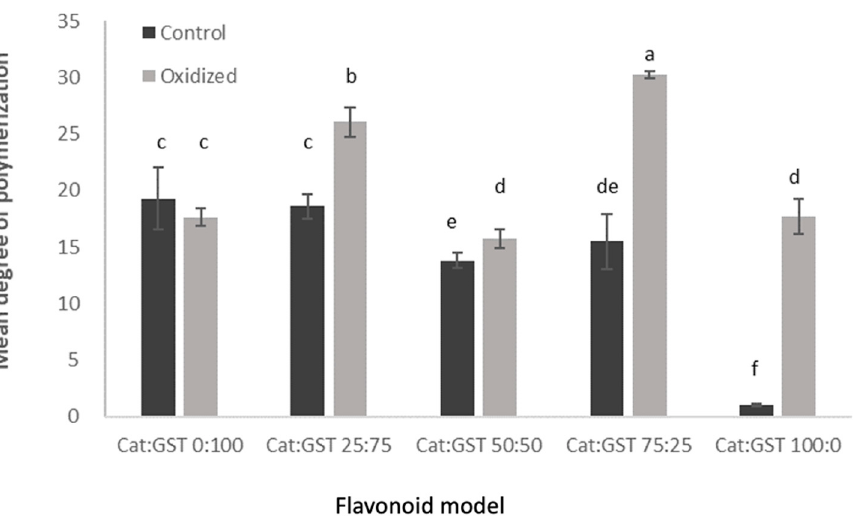
Figure 2. Mean degree of polymerization (mDP) of fl avonoid model. Means that do not share a le tt er (a–f) are significantly different ( p < 0.05). Error bars are standard deviation of replicate subsamples (a–f) are signi fi cantly di ff erent ( p < 0.05). Error bars are standard deviation of replicate subsamples samples (n = 3) and measured in samples (n = 3) and measured in triplicate.